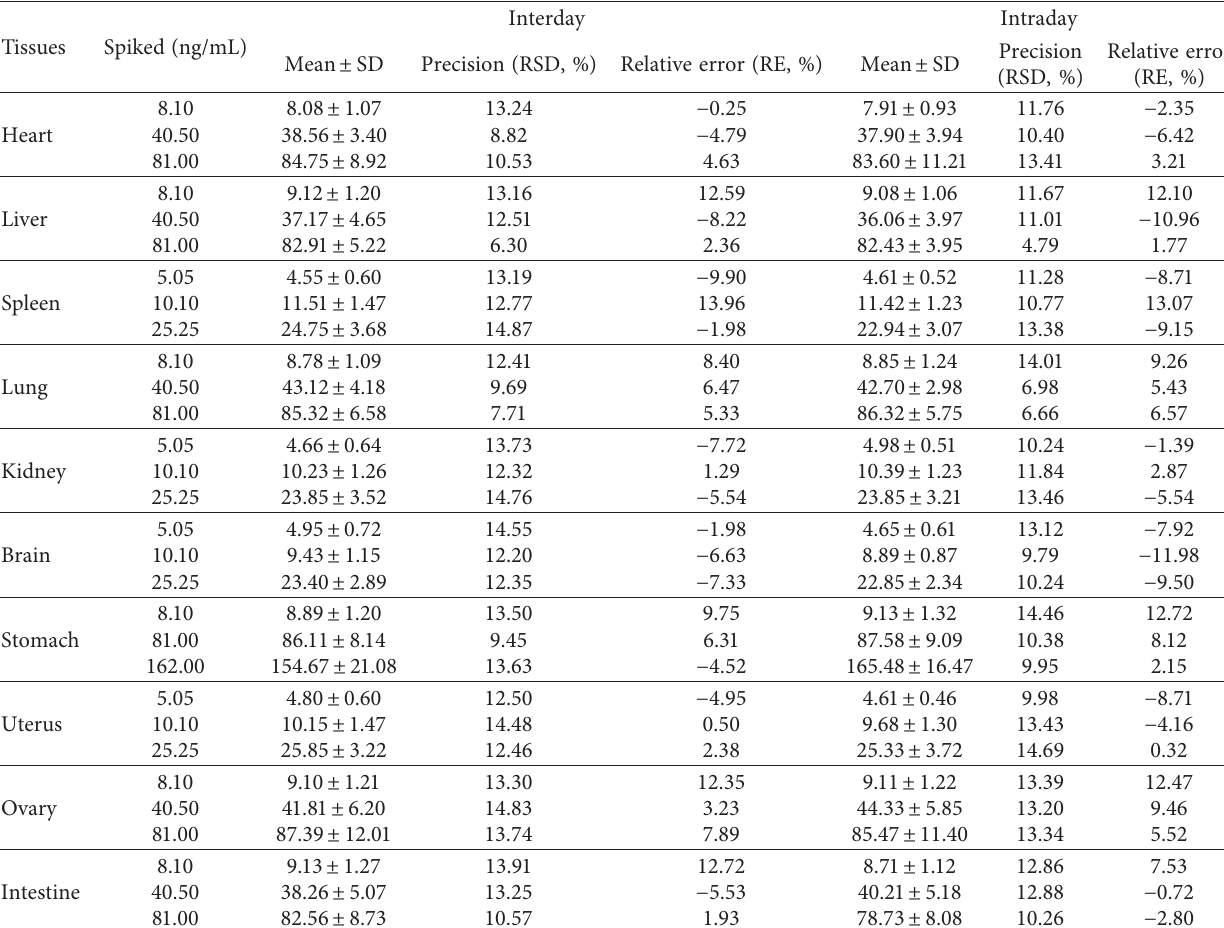
Table 5: Interday and intraday precision and accuracy data for assays of astragalin in different tissues ( n � 6). Tissues Spiked (ng/mL)